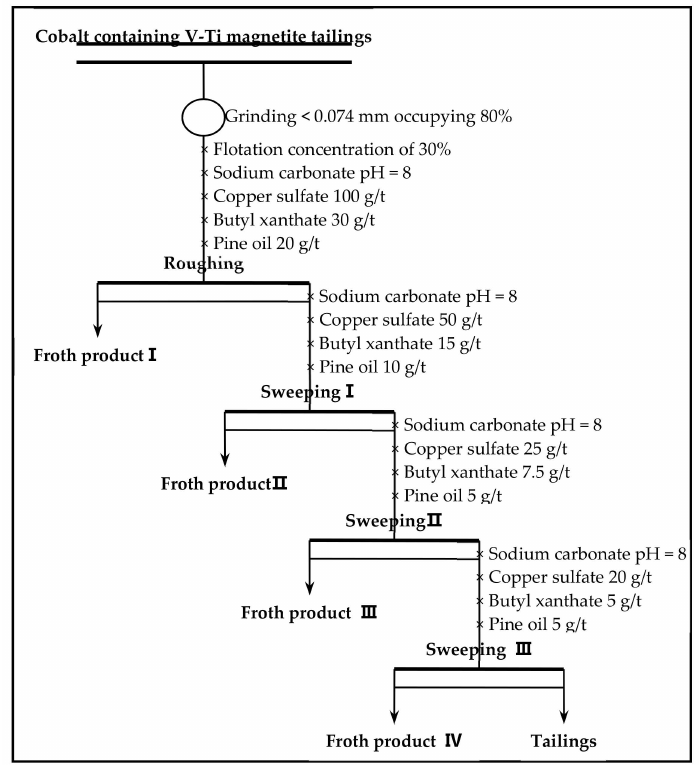
Figure 8. Time on flotation sweeping